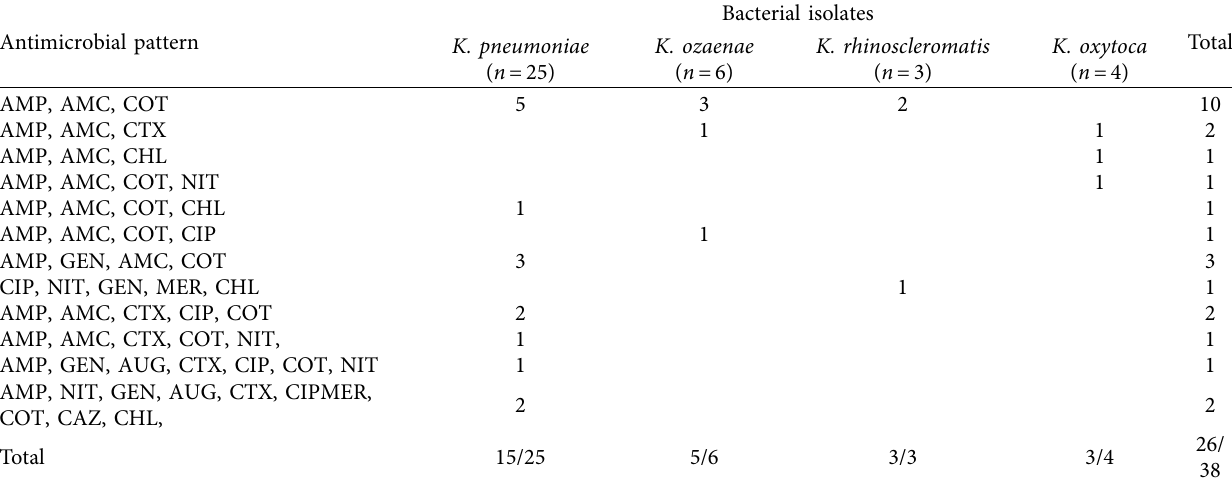
Table 3: Multidrug-resistant profile of Klebsiella species isolated from UTI-suspected patients who attended Bahir Dar City health in- stitutions, Bahir Dar, Northwest Ethiopia,